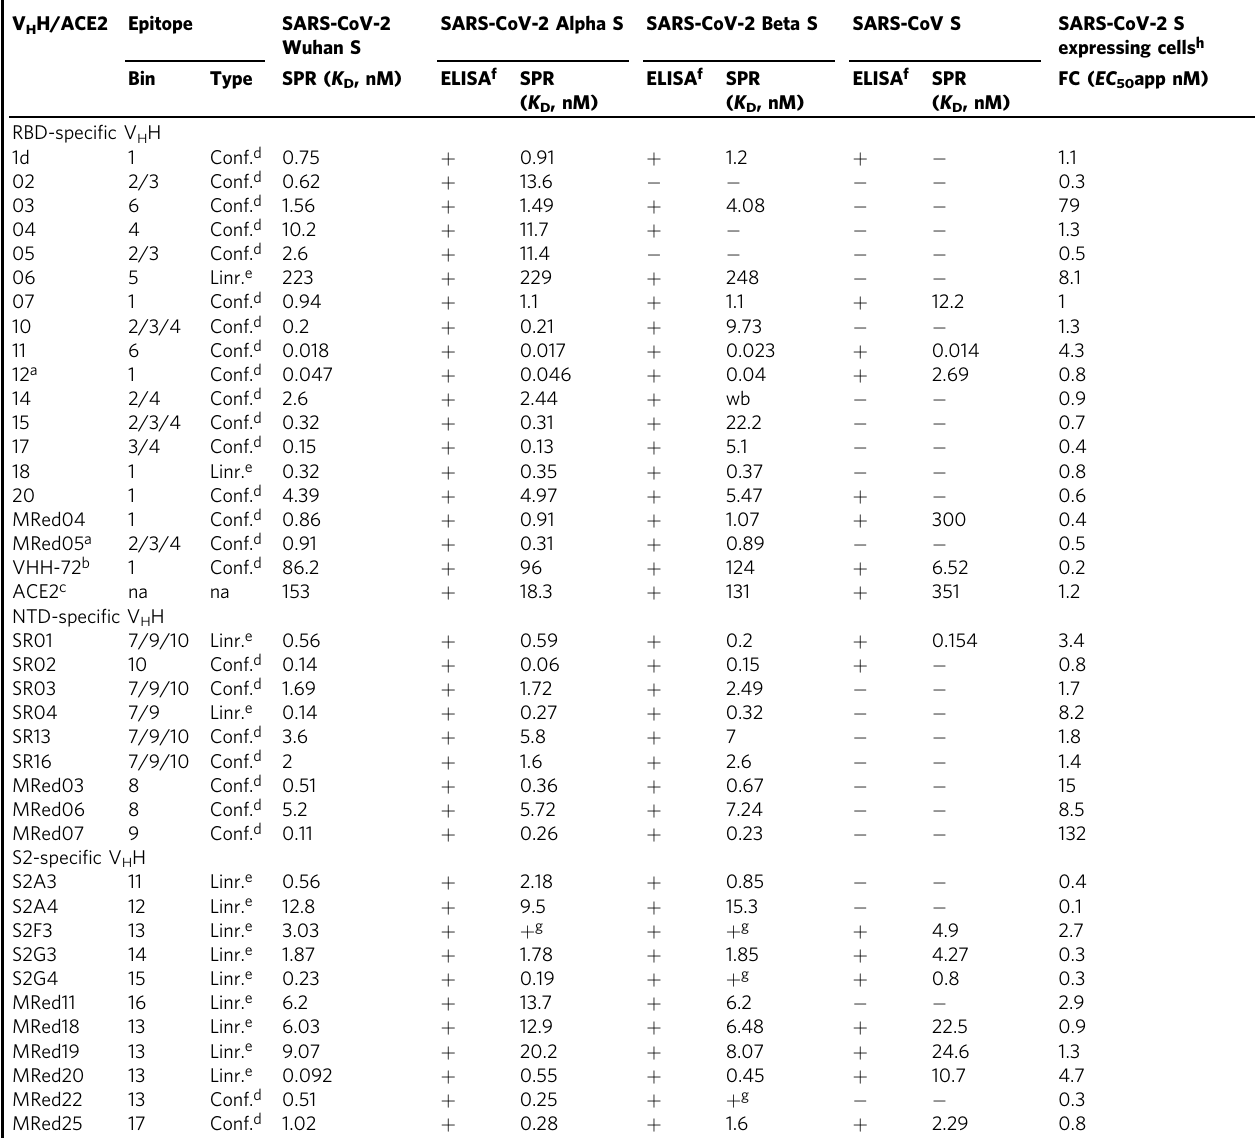
Table 1 Binding characteristics of SARS-CoV-2 V H Hs. V H H/ACE2